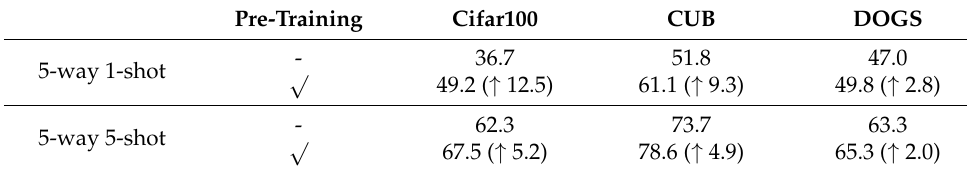
Table 2. Classification accuracies (%) of GNN with or without